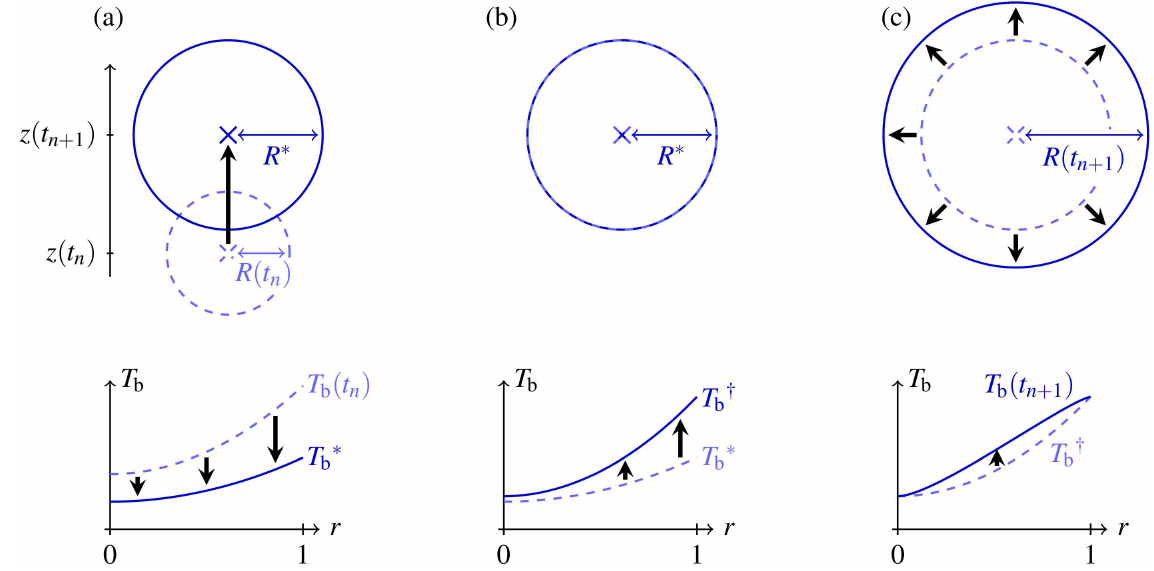
Fig. 5. Schematic representation of the three stages used in part 1 of the model to compute the balloon effective radius at time t n + 1 from the balloon effective radius at time t n . The upper panel shows the evolution of the balloon altitude and effective radius at each step, the lower panel indicates the corresponding changes in the temperature distribution inside the balloon. The notation used in the figure is introduced in Sect. 3. (a) Adiabatic expansion of the balloon from altitude z(t n ) to altitude z(t n + 1 ) . (b) Heat diffusion inside the balloon at constant pressure. (c) Correction to the balloon effective radius and temperature